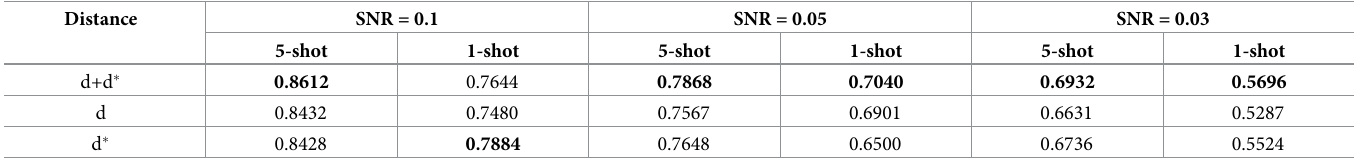
Table 2. The classification accuracy of the simulated datasets with different embedding distance used.